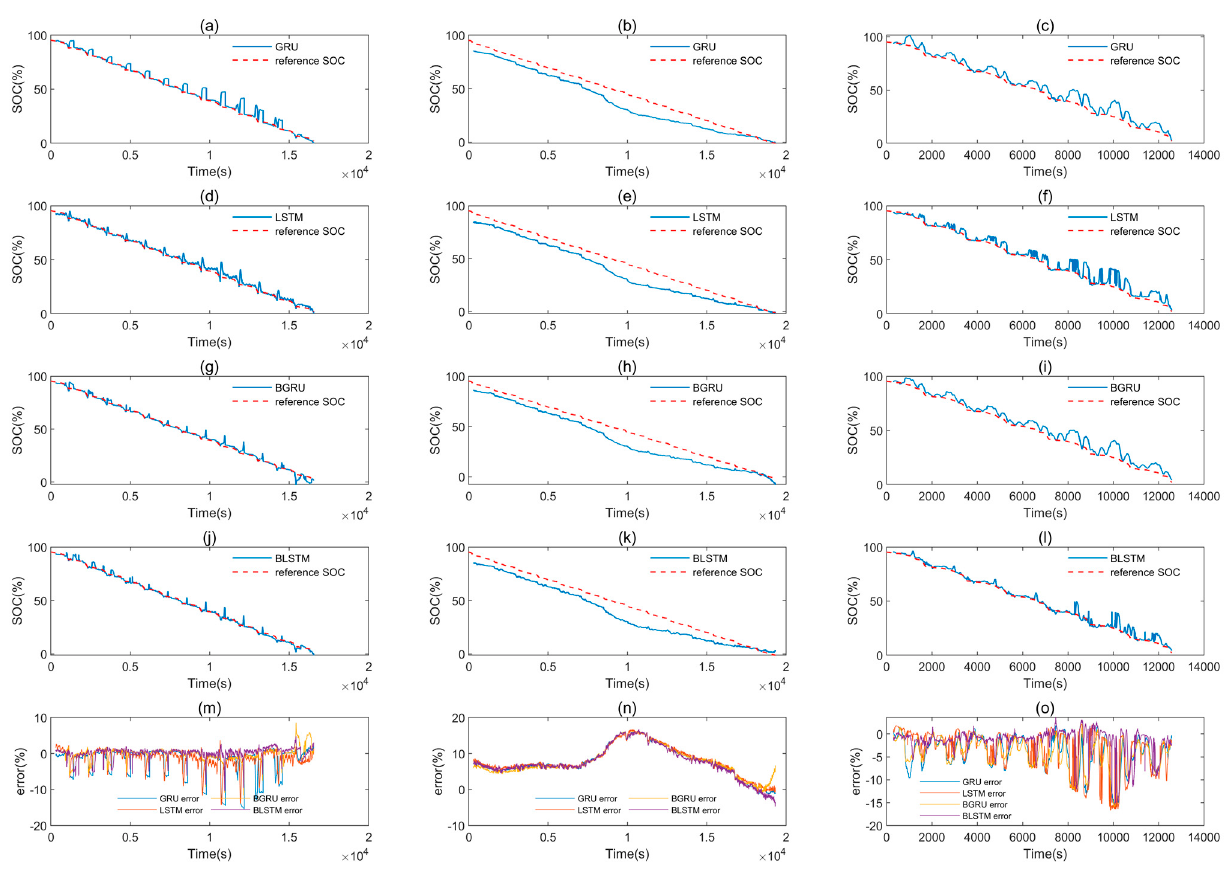
Figure 4. SOC estimation results for scenario 1: ( a – c ) SOC estimation using the GRU-based model;